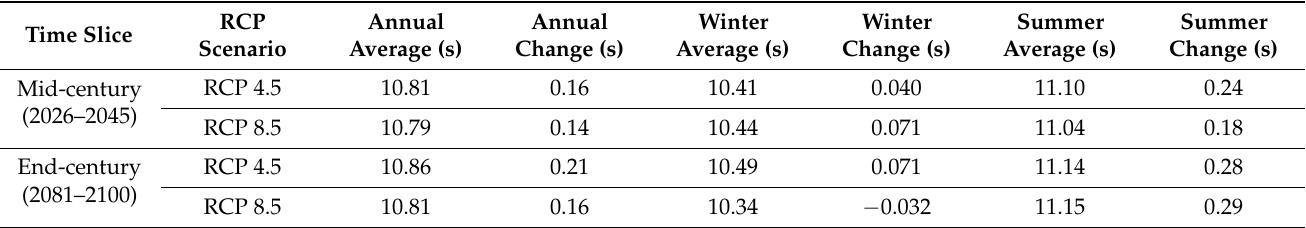
Table 7. Mid and end-century average extreme Tm and change relative to the past. Time